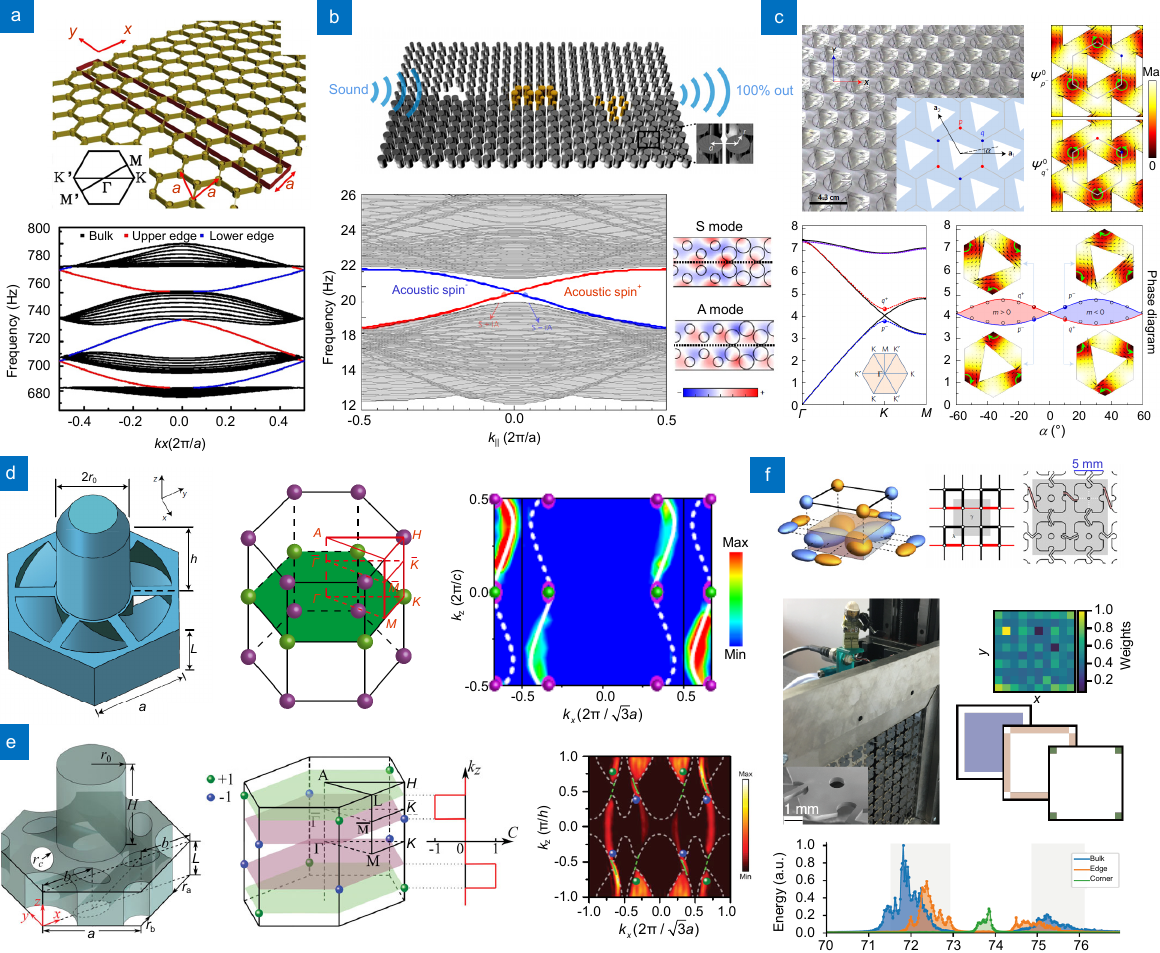
Fig. 7 | ( a ) Schematic of the topological Chern insulators (upper) and the projected band diagram of the sonic crystal (lower). The red and blue lines represent the edge states distributed on different edges. ( b ) Upper panel: schematic of the transmission of the acoustic quantum spin hall effect. Lower panel: calculated projected band diagram of the topological phononic crystal. The red and blue lines represent two pairs of interface states with opposite propagation directions distributed on different interfaces. ( c ) Upper panels: schematic of the two dimensional acoustic phononic crystal (left) and the valley states (right). Lower panels: the band diagram (left) and the band transition diagram (right). ( d ) Schematic of the phononic crystal of type-I Weyl points (left) and the distribution of type-I Weyl points in Brillouin zone (middle). Fourier transforms of the surface wave fields on the XZ plane that show the Fermi arc of type-I Weyl points(right). ( e ) Schematic of the phononic crystal of type- II Weyl points (left) and the distribution of type- II Weyl points in Brillouin zone (middle). Fourier transforms of the surface wave fields on the XZ 1 plane that show the Fermi arc of type-II Weyl points (right). ( f ) Upper panels: schematic of the quantized quadrupole (left), the corresponding tight bound model (mid- dle) and the corresponding structural unit (right). Middle panels: diagram of experimental equipment (left) and the corresponding distribution of the bulk, edge and corner response at an arbitrary frequency (72.0 kHz) (right). Lower panel: the frequency regions of bulk, edge and corner states. Figure reproduced from: (a) ref. 230 , Institute of Physics; (b) ref. 233 , Nature Publishing Group; (c) ref. 234 , Nature Publishing Group; (d) ref. 238 , Nature Publishing Group; (e) ref. 239 , American Physical Society; (f) ref. 248 , Nature Publishing